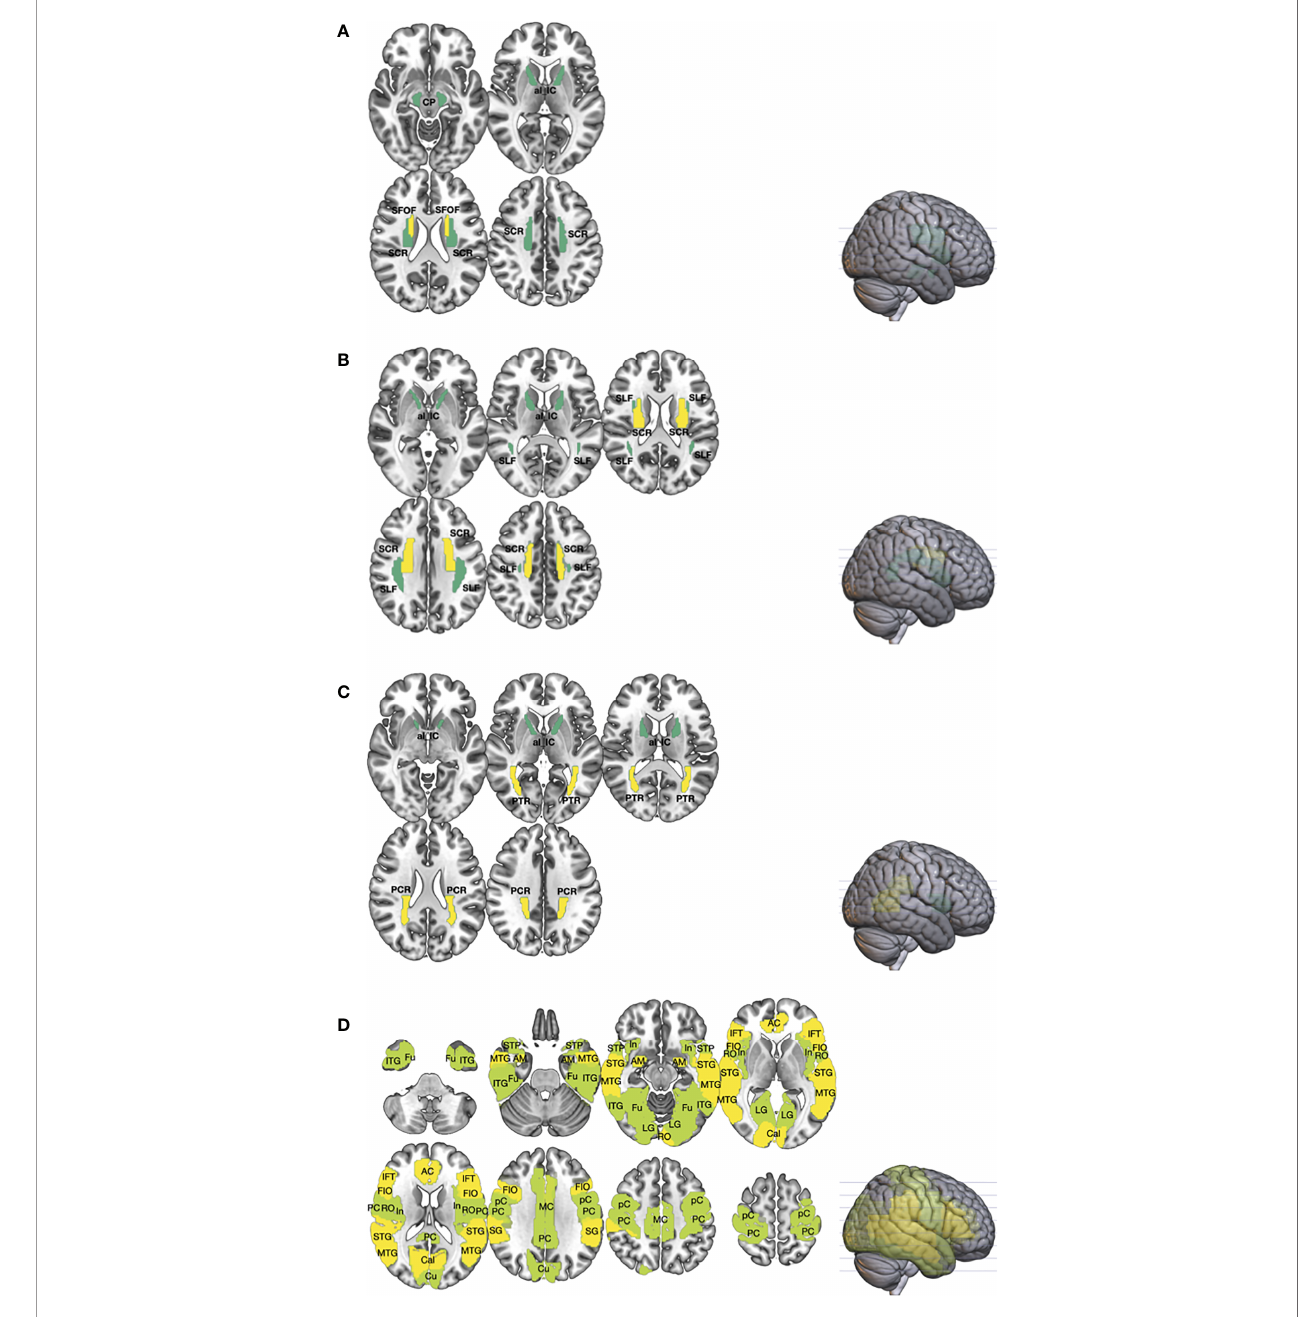
FIGURE 1 | The differences in the white (WM; (A – C) and gray matters (GM; (D) between germ cell tumor (GCT; n = 20) survivors and healthy age, sex-matched controls (n = 14) were investigated using diffusion metrics, namely mean diffusivity (MD), fractional anisotropy (FA), and mean kurtosis (MK), obtained from diffusional kurtosis imaging (DKI). Region-of-interest (ROI) measurement of the cortical and subcortical regions, from the Automated anatomical labeling (AAL) atlas, and major WM tracts, from the Johns Hopkins white matter atlas, were performed. The brain regions that showed statistically signi fi cant difference in diffusion metrics between GCT and healthy controls were shown ( P < 0.01 in yellow; P < 0.05 in green). As compared to healthy controls, ROI analyses of the WM showed that the MD (A) of GCT survivors in the cerebral peduncle (CP), superior corona radiata (SCR), anterior limb of internal capsule (al_IC), and superior fronto-occipital fasciculus (SFOF) were higher; the MK (B) in the superior longitudinal fasciculus (SLF), SCR, and al_IC were lower; and the FA (C) in the posterior corona radiata (PCR), posterior thalamic radiation (PTR), and ac_IC were lower. Region-of-interest analysis of the GM (D) showed that the MD of GCT in fusiform (Fu), inferior temporal gyrus (ITG), middle temporal gyrus (MTG), superior temporal pole (STP), superior temporal gyrus (STG), amygdala (AM), insular (In), lingual gyrus (LG), rolandic operculum (RO), anterior cingulum (AC), middle cingulum (MC), posterior cingulum (PC), calcarine (Cal), cuneus (Cu), precentral gyrus (pC), postcentral gyrus (PC), supramarginal gyrus (SG), frontal inferior operculum (FIO), and inferior frontal triangularis (IFT) were signi fi cantly higher than those of healthy